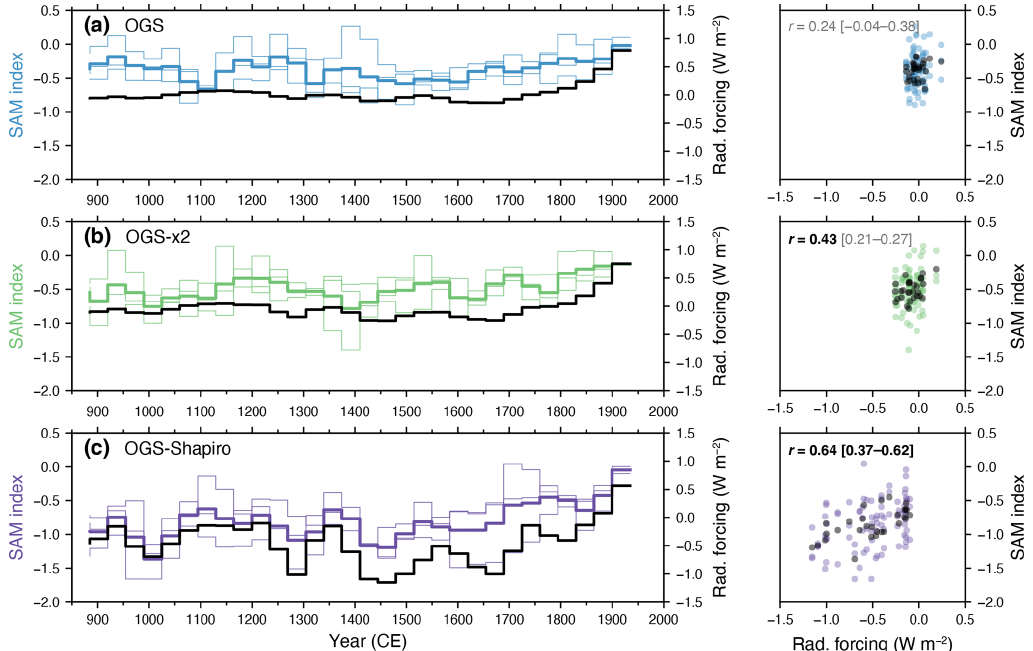
Figure 8. SAM index response to different amplitudes of transient solar forcing during the last millennium. Time series (left column) of the SAM index (coloured lines; ensemble mean: thick line; ensemble members: thin lines) and radiative forcing anomalies (black) in the transient experiments with (a) low-, (b) intermediate-, and (c) high-amplitude solar forcing. Time series shown for the SAM index are calculated relative to 1900–1999 climatology, and long-term changes are represented as 70-year moving averages stepped by 35 years. Scatter plots (right column) show the 850–1900CE correlation between 70-year moving averages stepped by 35 years of the SAM index and radiative forcing anomalies in the ensemble mean (black, first r value) and ensemble members (coloured, r values in square brackets give ranges across ensemble members); r values in bold text are where P < 0 . 05, while r values in grey text are where there is no significant relationship. Correlations are limited to 850–1900CE to avoid the influence of recent anthropogenic greenhouse gas influences on the radiative forcing–SAM